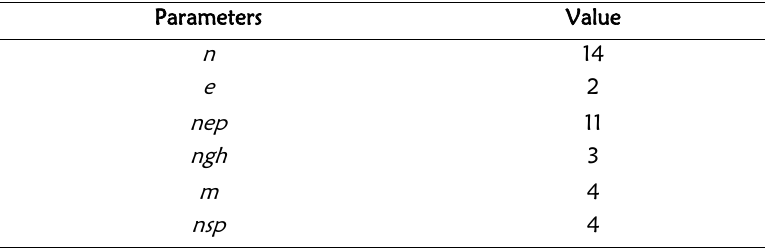
Table 1: Set of Parameters of the Bees